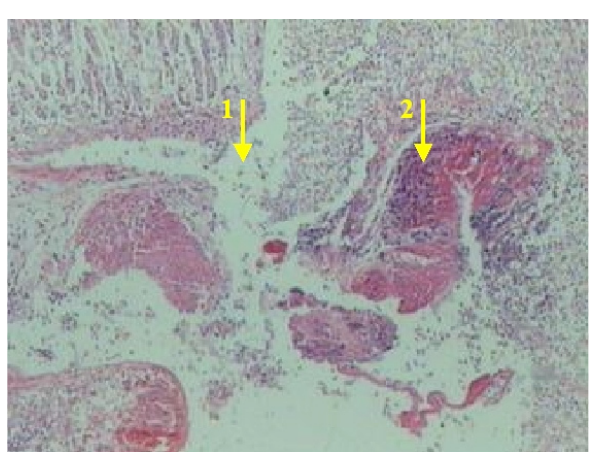
FIGURA 4 – Fotomicrografia da reação inflamatória aguda. Legenda: Rato 7, GA, 3º dia de P.O. (M.O., coloração HE, aumento de 100x). Nota: 1 = mucosa gástrica. 2 = inflamação aguda